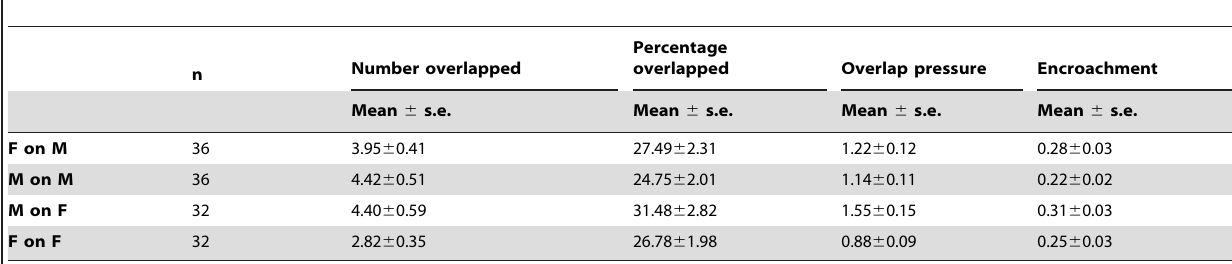
Table 2. Summary of home range measures in B. vitiensis for adult males with 10 or more sightings (n =36) and adult females with 6 or more sightings